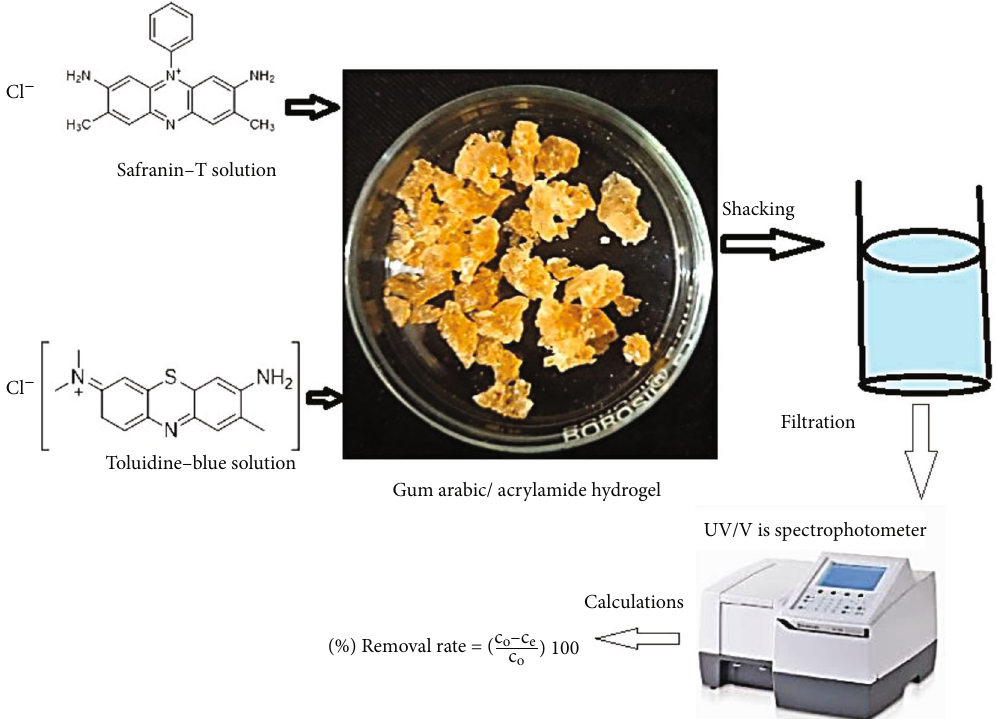
Scheme 1: Schematic representation of the adsorption